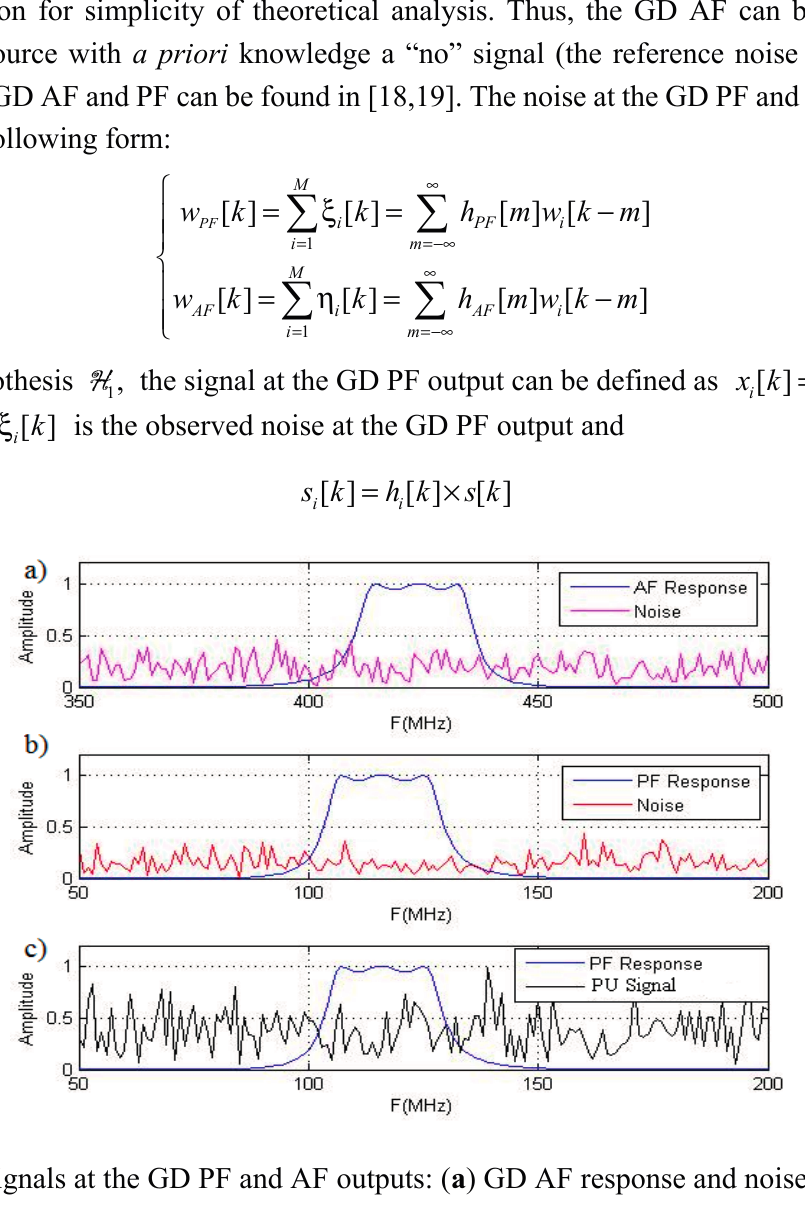
Figure 3. Signals at the GD PF and AF outputs: ( a ) GD AF response and noise; ( b ) GD PF response and noise; ( c ) GD PF response and PU